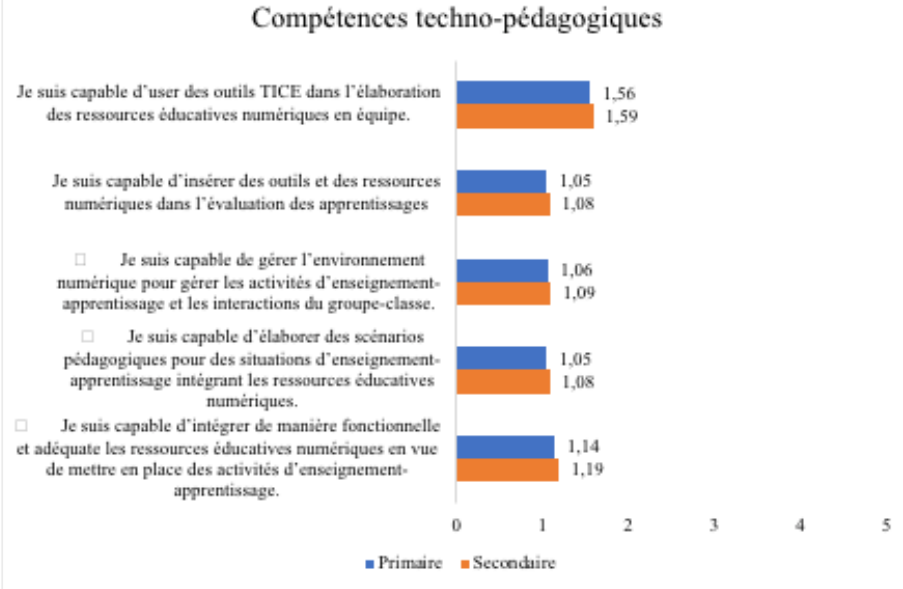
Fig. 11. Les compétences techno-pédagogiques déclarées maîtrisées à l’issu de la formation au